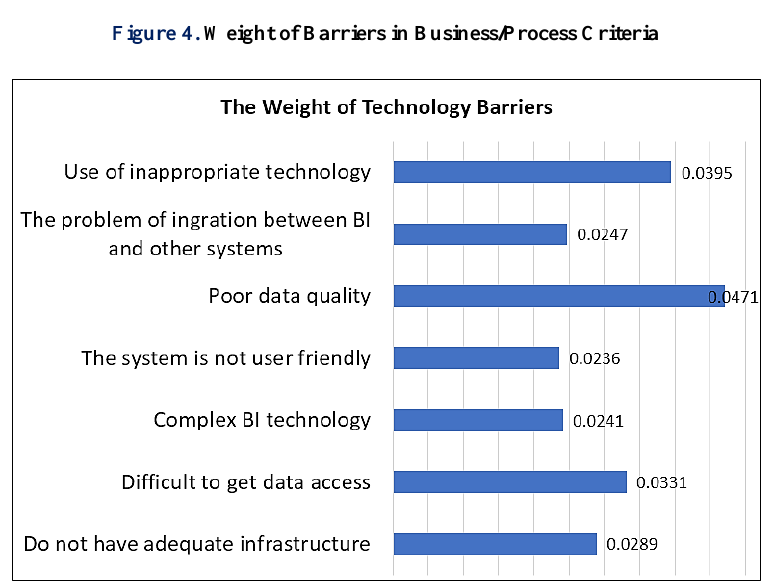
Figure 5. Weight of Barriers in Technology